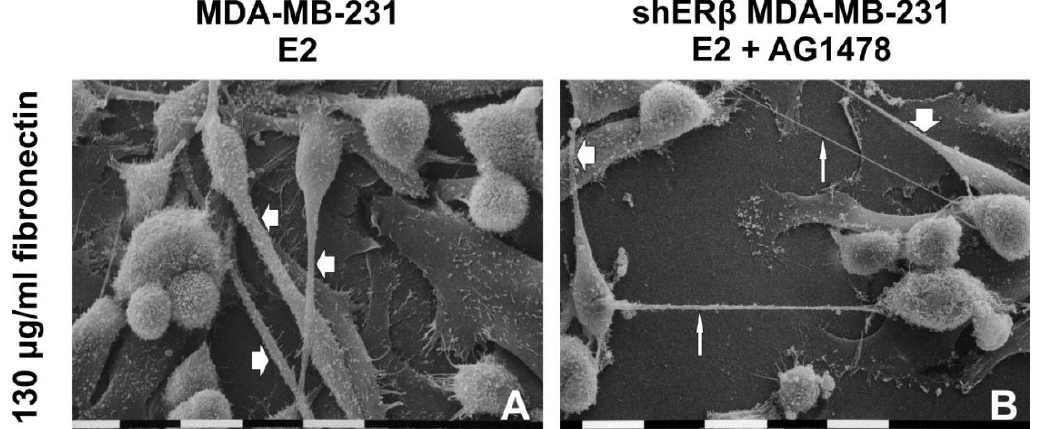
Figure 7. ( A ) MDA-MB-231 cells treated with E2 and cultivated on a Millipore filter coated by 130 µg/mL FN: Flattened-polygonal cells adhering to the collagen substrate are covered by globular and elongated-fusiform cells showing microvilli and EVs. Long conical-shaped filopodia (large arrows) including microvilli and EVs on their surface arise from elongated-fusiform cells. Bar = 10 µm. ( B ) shER β MDA-MB-231 cells treated with both E2 and AG1478 (mix) and cultivated on a Millipore filter coated by 130 µg/mL FN: Globular and elongated-fusiform cells on the Millipore filter are detectable. Long filopodia (large arrows) developing from elongate cells and straight intercellular TNTs (narrow arrows) with EVs on their surface are visible. Bar = 10 µm.